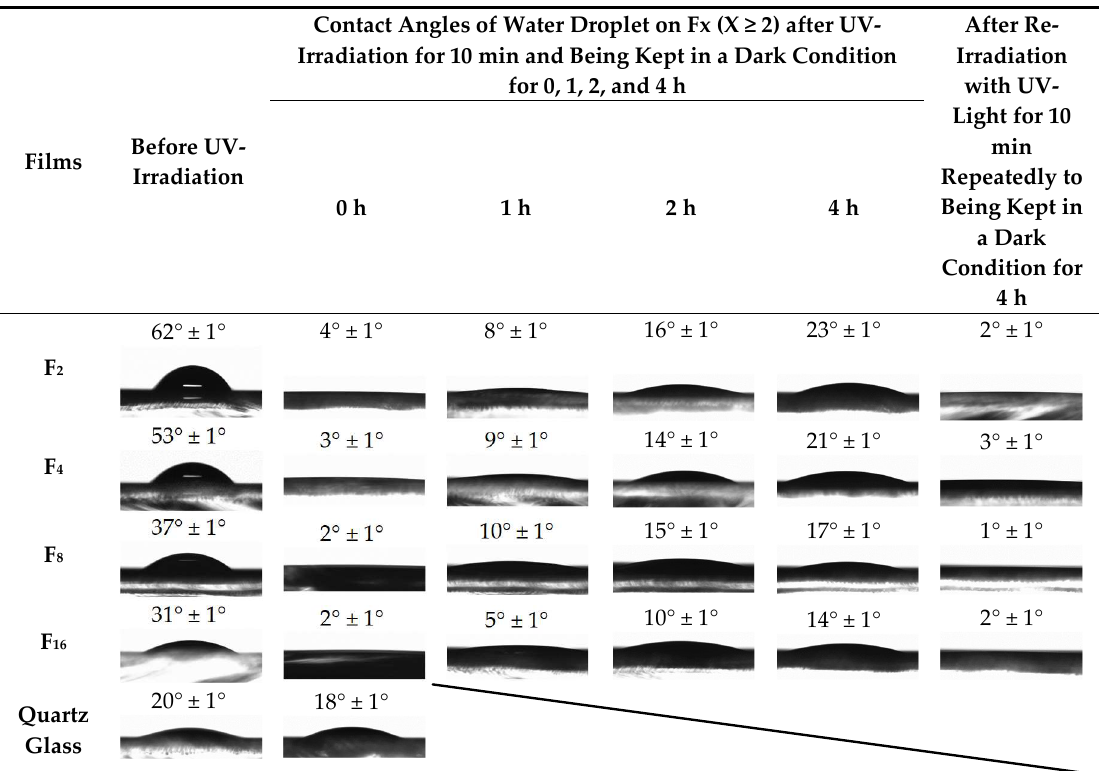
Table 2. Contact angles of a water droplet on F x (x ≥ 2) prior to and after photo-induction by UV irradiation for 10 min, together with the photographic images captured from the side and those on the quartz glass substrate. The measurements were performed after the samples were kept for 0, 1, 2, and 4 h in a dark condition. The contact angles of the photo-induced samples (whose contact angles were once examined after being kept in a dark condition for 4 h) subsequent to the second UV-irradiation for 10 min are also